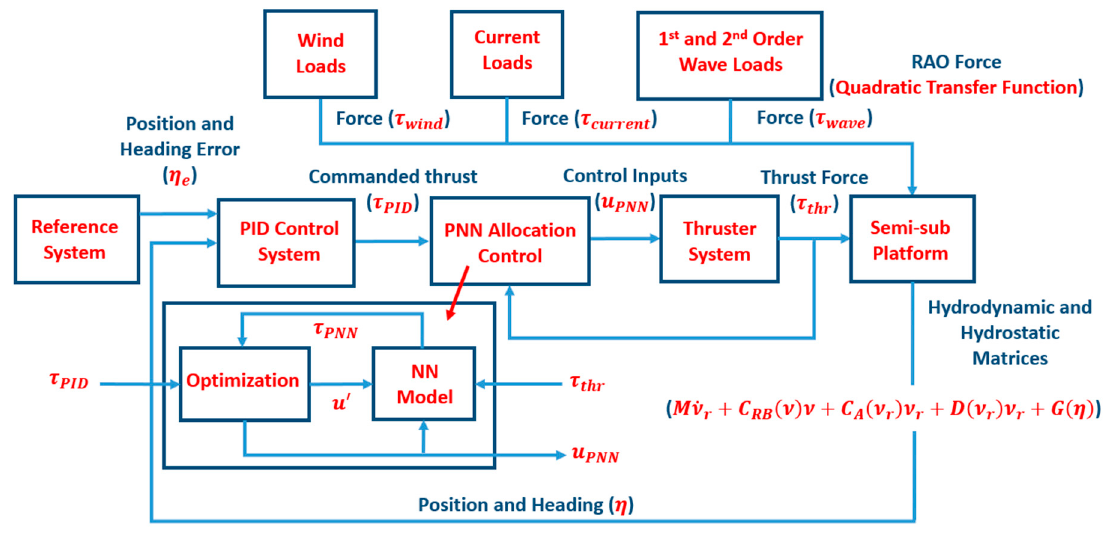
Figure 9. Dynamic Positioning (DP) Simulation with PID motion and PNN allocation controls.